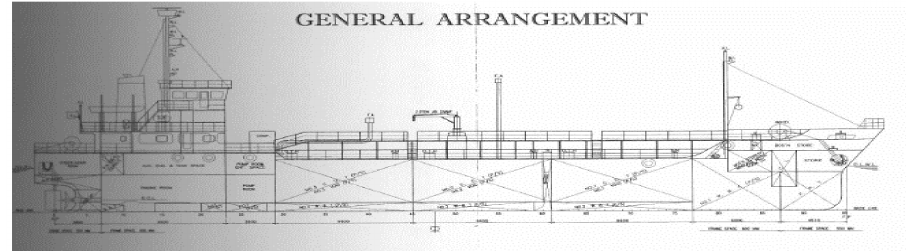
Figure A1. Drawing of the general layout of “Ship